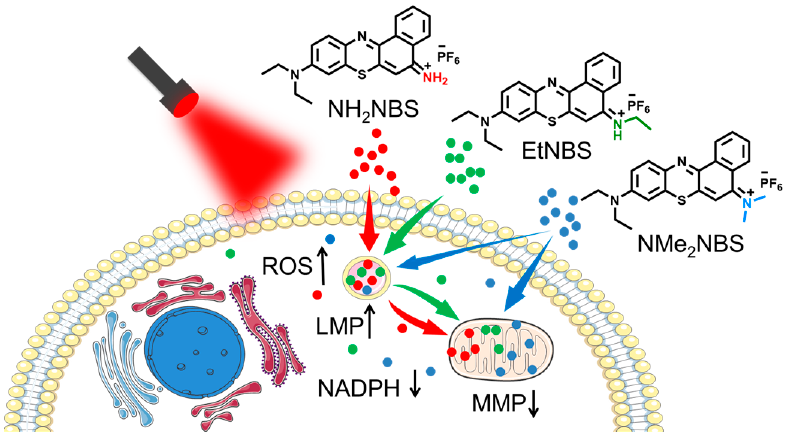
Scheme 1. Schematic illustration of the intracellular dynamic process by complexes NH 2 NBS, EtNBS, and NMe 2 NBS during